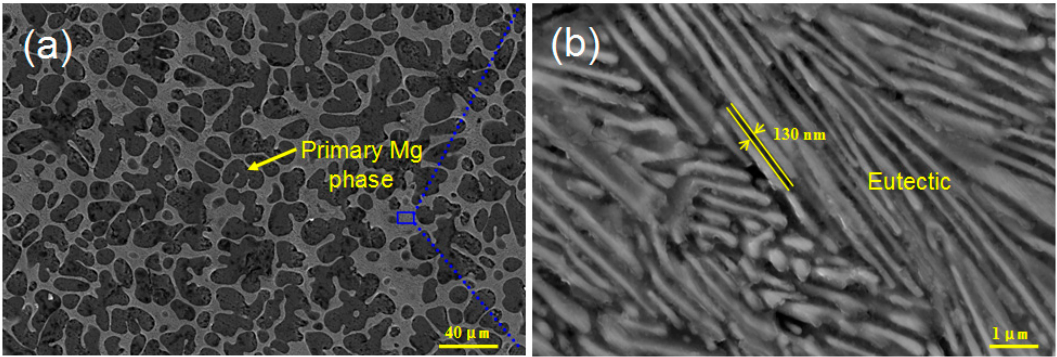
Figure 1. ( a ) Microstructure of Mg–8.8Ni alloy (designated as alloy A in this study), and ( b ) the magnified scanning electron microscopy image of the eutectic region.